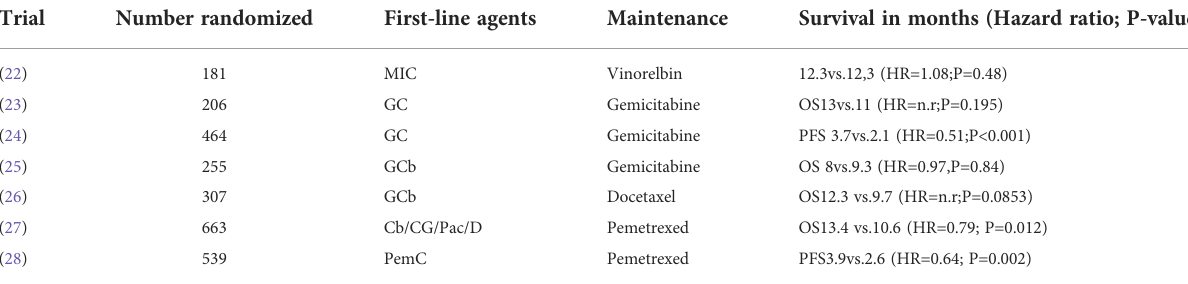
TABLE 1 Chemotherapeutics agents in maintenance designed trials.